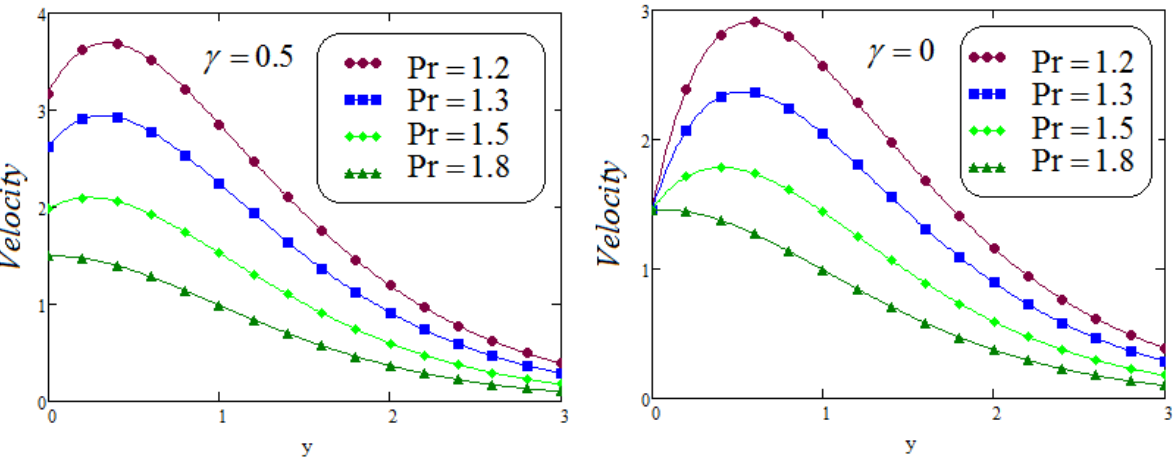
Figure 3. Velocity profile for varied values of P r with and without slip effect γ when f ( t ) = e at , a = 0.25, t = 1.5, α = 0.5, β = 0.3, Gr = 3.5, λ 1 = 0.6, λ 2 = 0.2, M =